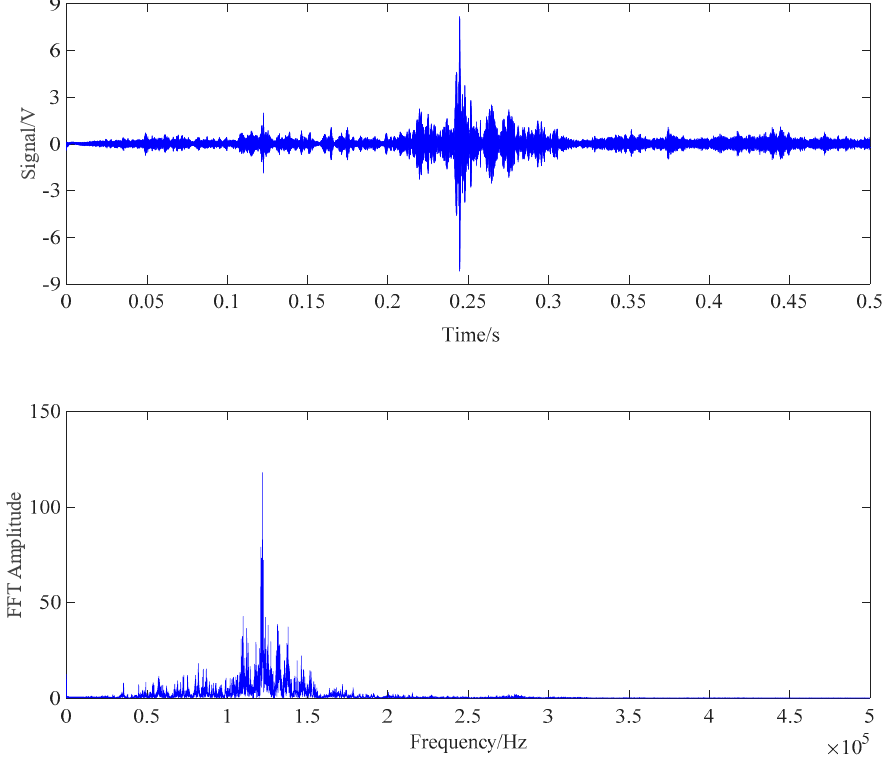
Figure 20. Received signals and its Fourier spectrum of PZT BC combination.